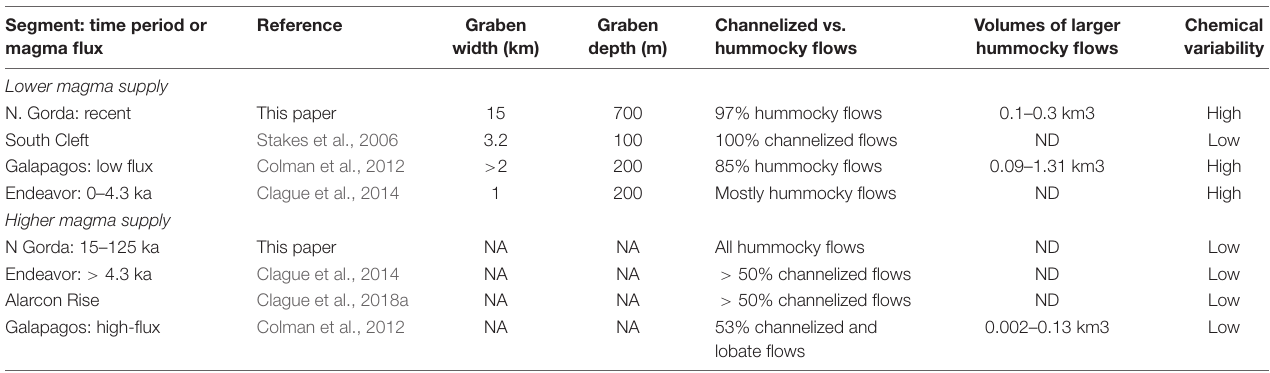
TABLE 2 | Intermediate-rate pacific ridge